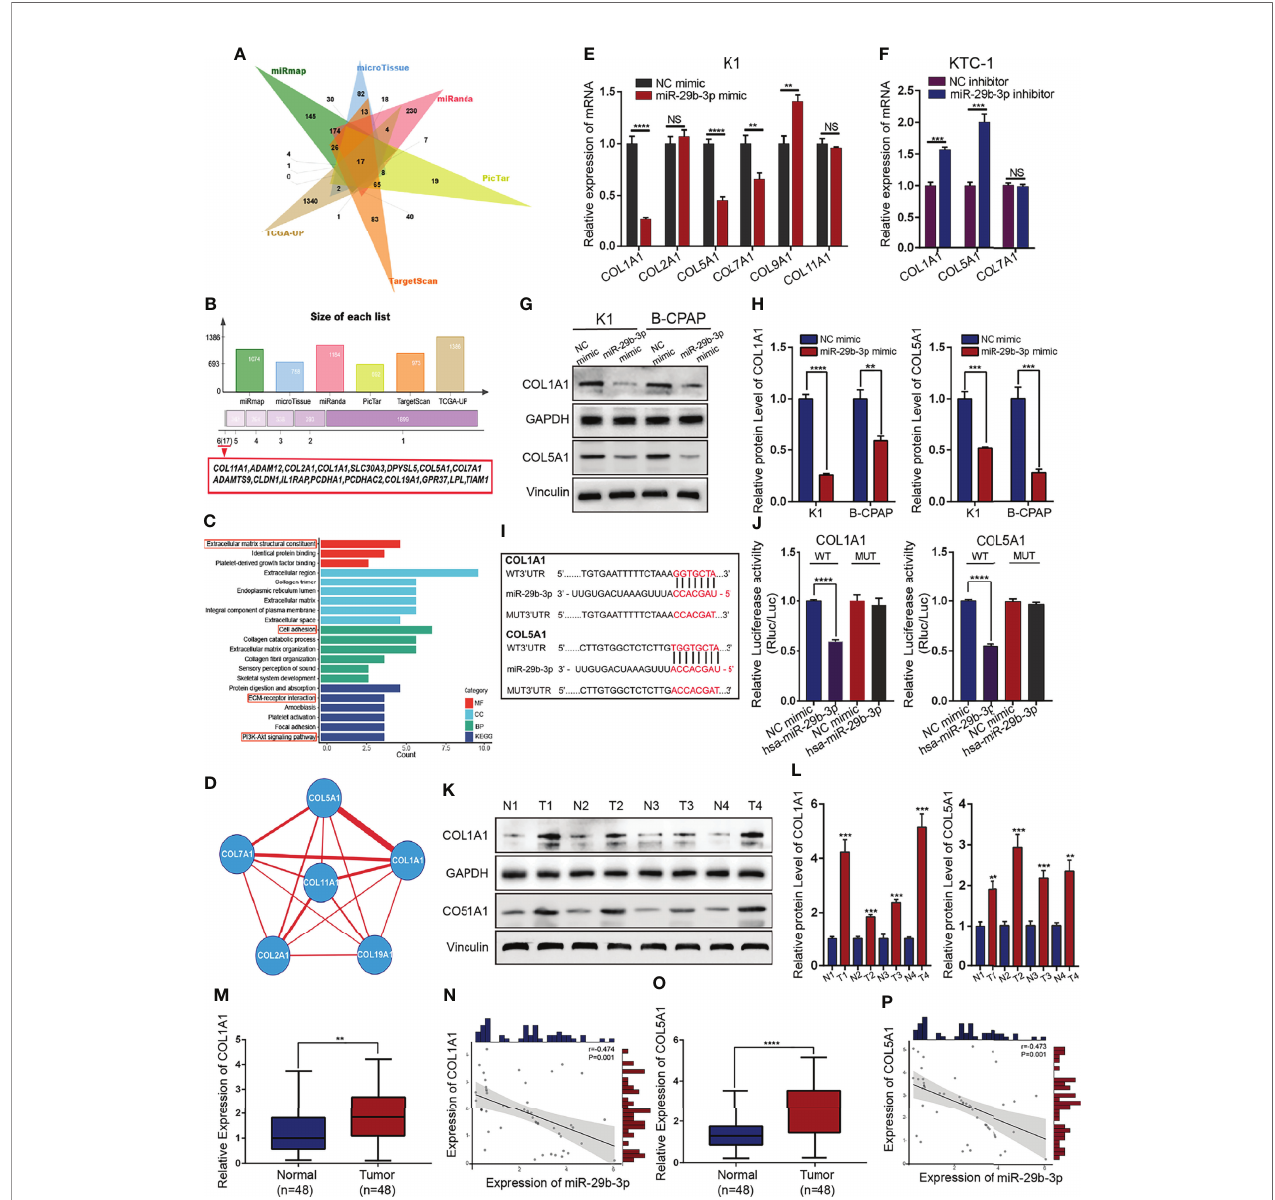
FIGURE 3 | COL1A1 and COL5A1 as direct targets of miR-29b-3p in PTC tissues. (A, B) The bioinformatic predictions of miR-29b-3p candidate target genes and Venn diagram depicting the overlap of target genes predicted by fi ve miRNA databases (miRmap, microTissue, miRanda, PicTar, and TargetScan) and TCGA datasets. (C) GO and KEGG enrichment analysis of candidate miR-29b-3p target genes. (D) The miR-target gene regulatory network constructed using Cytoscape. (E, F) Fold change in mRNA expression of six candidate target genes upon transfection of miR-29b-3p mimic/inhibitor and validation of COL1A1 and COL5A1 as the direct target genes of miR-29b-3p by qRT-PCR. (G, H) Western blot analysis of COL1A1 and COL5A1 expression after transfection with miR-29b-3p mimics. (I, J) The 3-UTRs of COL1A1 and COL5A1 as potential binding sites for miR-29b-3p, determined by the luciferase assays. ( K, L ) Western blots showing the relative protein expression levels of COL1A1 and COL5A1 in PTC tissues and adjacent non-cancerous normal tissues from four patients. (M – P) Relative expression levels of COL1A1 and COL5A1 in 48 paired human PTC tissues and adjacent non-tumor thyroid tissues, as evaluated by qRT-PCR. Both COL1A1 and COL5A1 mRNA highly expressed in PTC tissues and negatively correlated with miR-29b-3p expression. In the fi gure, **p < 0.01, ***p < 0.001, ****p < 0.0001; NS, not signi fi